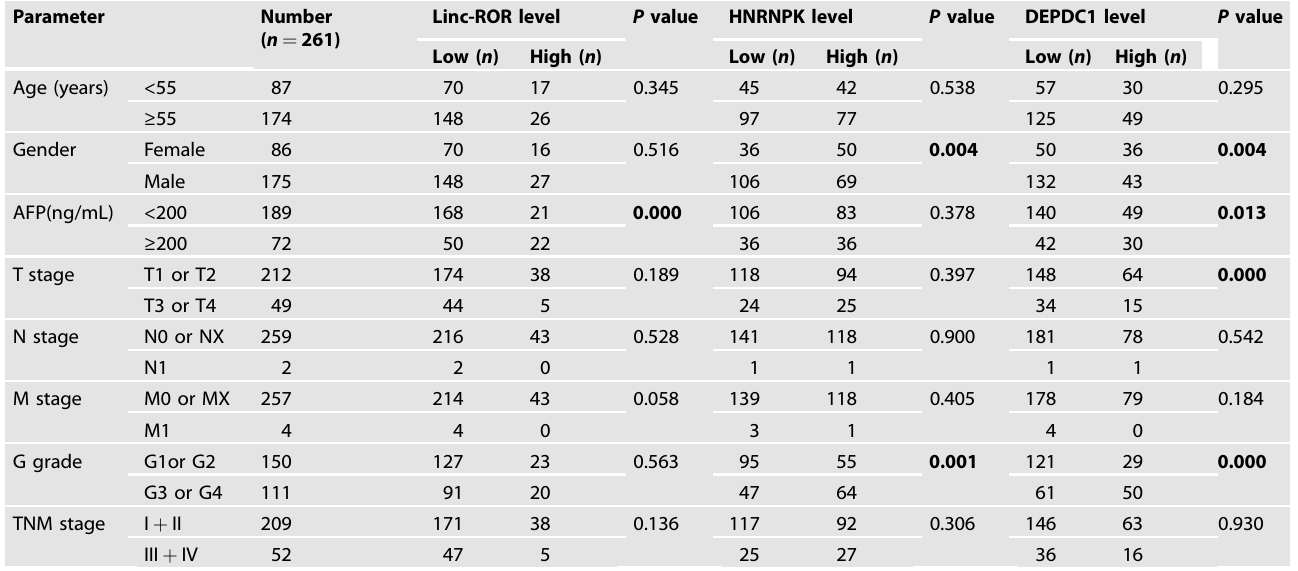
TNM tumor-node-metastasis, AFP a-fetoprotein, DEPDC1 DEP domain containing 1, HNRNPK heterogeneous nuclear ribonucleoprotein K, HCC hepatocellular carcinoma. It is statistically signi fi cant, that is